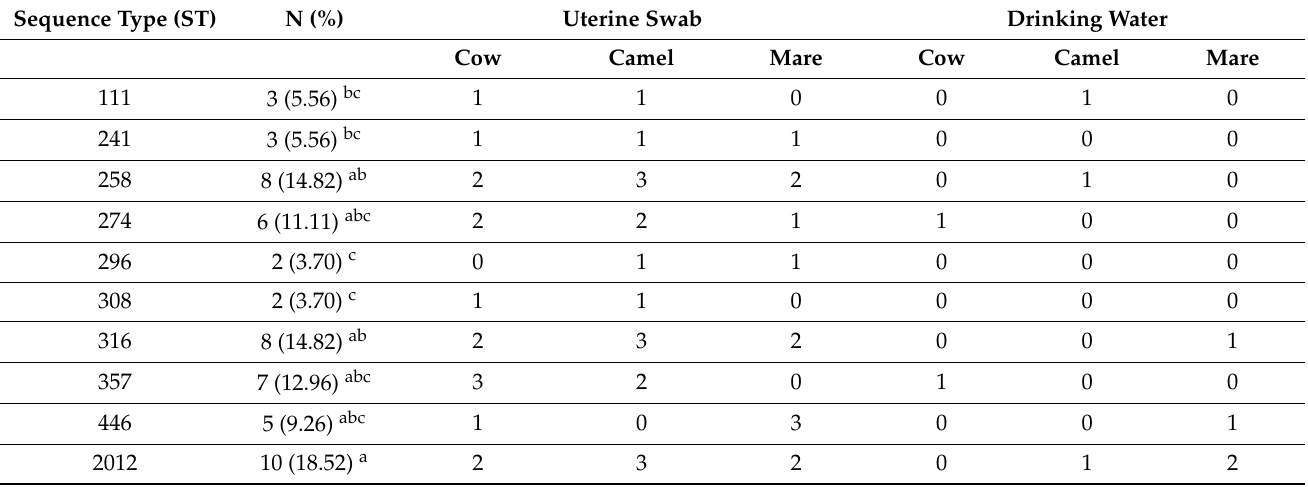
Table 2. The number of strains for each sequence type for P. aeruginosa isolates ( n = 54). Sequence Type (ST) Uterine Swab Drinking Water Cow Camel Mare Cow Camel